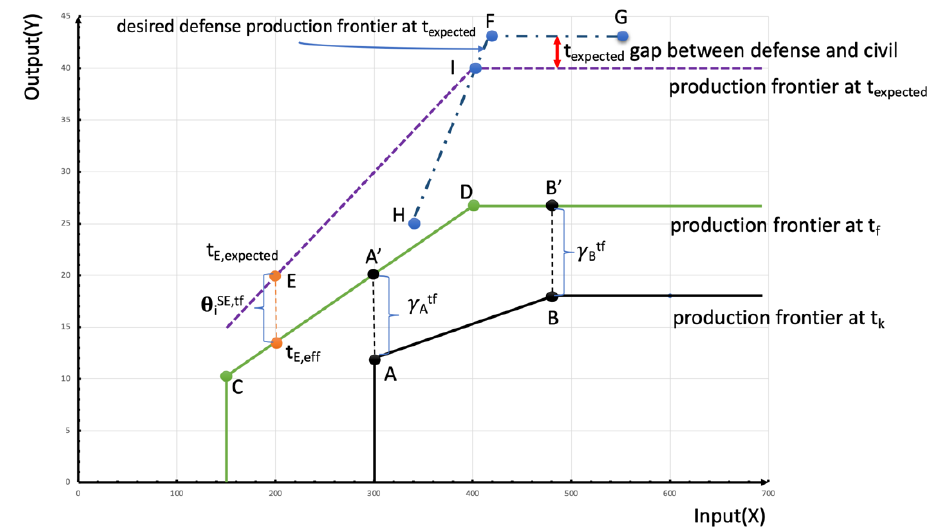
Figure 1. Desired defense production frontier.